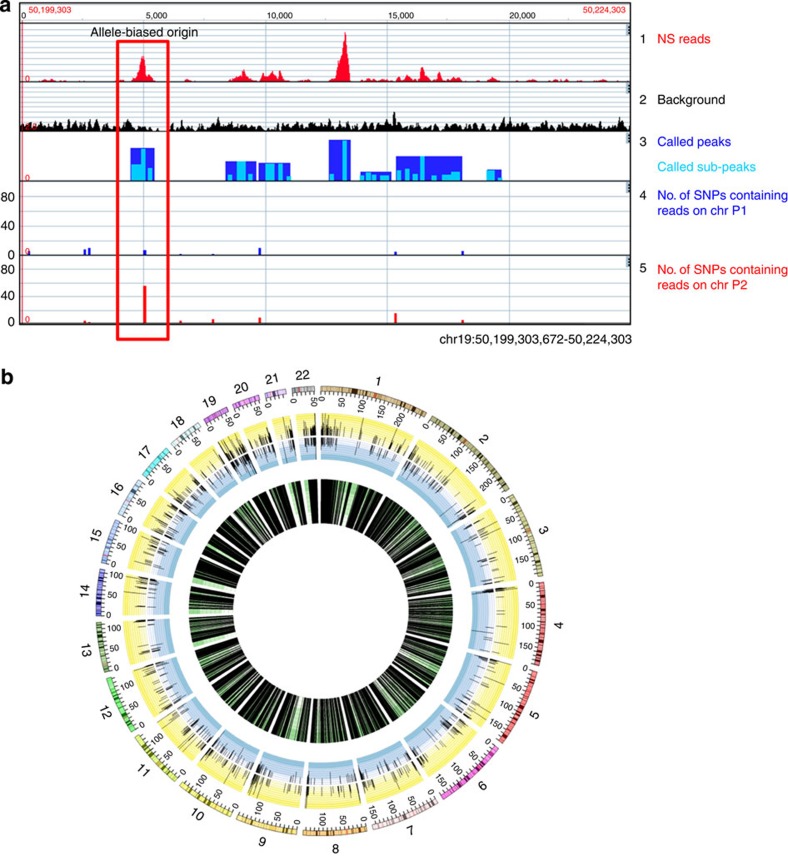
Allele-specific NS analysis.(a) GenPlay genome browser screenshot illustrating allele-specific NS sequencing analysis. Track 1: uniquely aligned NS reads binned in 10-bp windows. Track 2: background track obtained by sequencing DNA from control white blood cells from same individual. Track 3: peaks (dark blue) and subpeaks (light blue) called using the MACS software. Tracks 4 and 5: allele depth of phased heterozygous SNPs in FNY01_2_2 in chromosomes P1 (track 4) and P2 (track 5). The red rectangle highlights an allele-biased origin of replication (see text). (b) Circos plot illustrating the location of all allele-biased origins. Green (inner) circle: location of all origins analysable in an allele-specific manner. Outer circle shows the log2 ratio of P1/P2 reads in allele-biased origins (blue, negative; yellow, positive values).